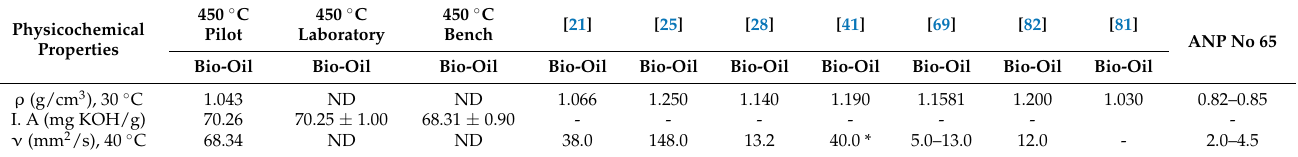
Figure 7. Yields of reaction products in laboratory, bench, and pilot scales. Table 3. Physico-chemical properties of bio-oil obtained by pyrolysis of dried Aça í seeds at 450 ◦ C and 1.0 atmosphere, compared to similar data reported in the literature